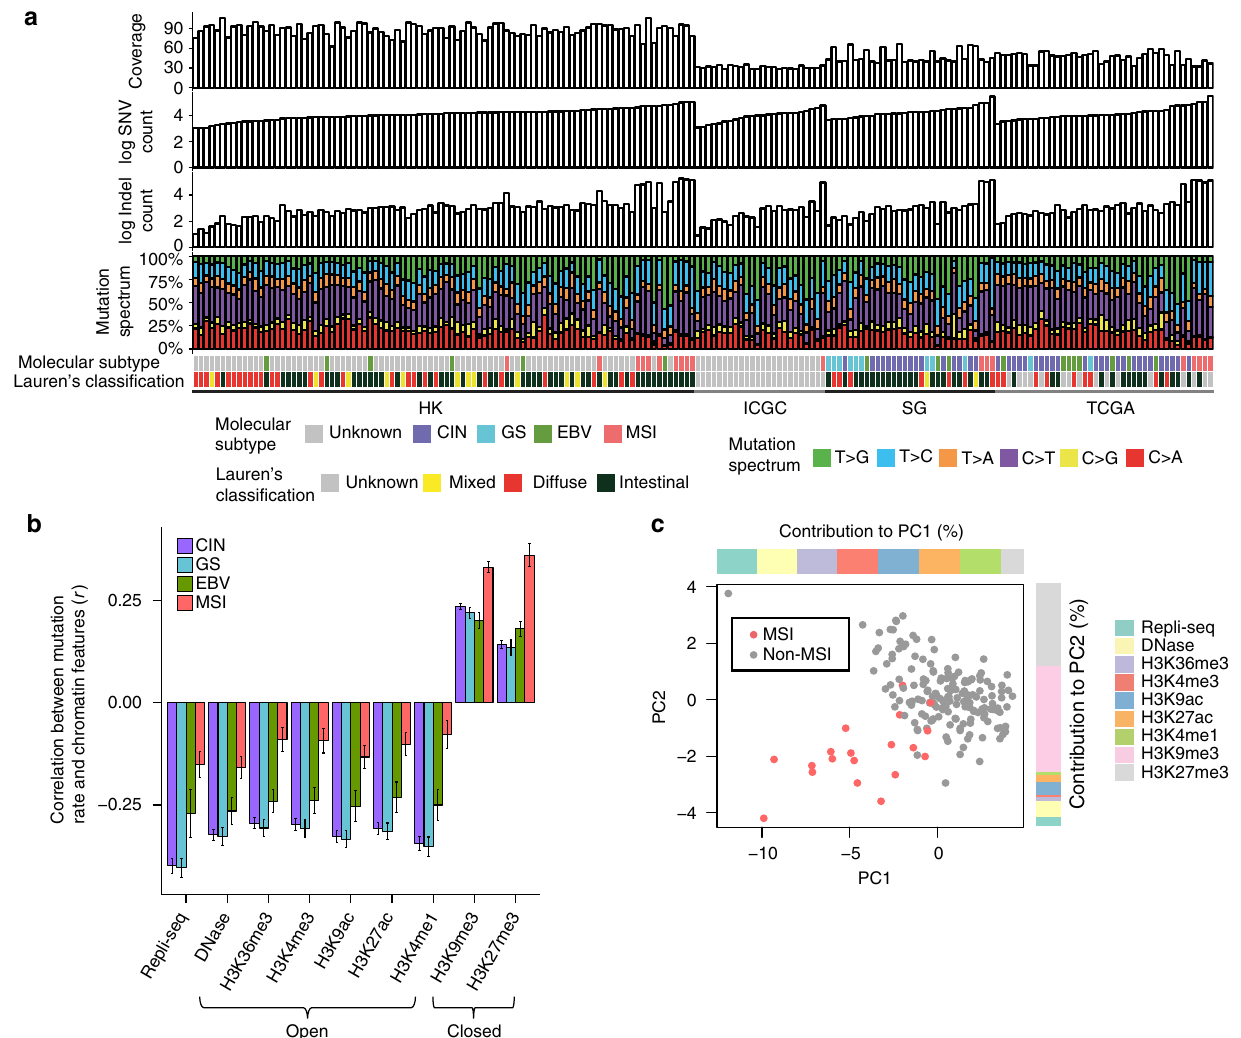
Fig. 1 Summary of the data. a Gastric tumor samples grouped by cohort and ordered by SNV count within each cohort. The panels show coverage, SNV count, indel count, mutation spectrum, molecular subtype, and Lauren ’ s classi fi cation of each sample. b Correlations between epigenetic features and somatic mutation rates in different tumor subtypes (error bars represent s.e.m of the correlation coef fi cient). c Principle component analysis of contributions of epigenetic features to the variance in the mutation rate of individual tumors. Colored stacked bars show the contribution of individual epigenetic features to the fi rst two principal